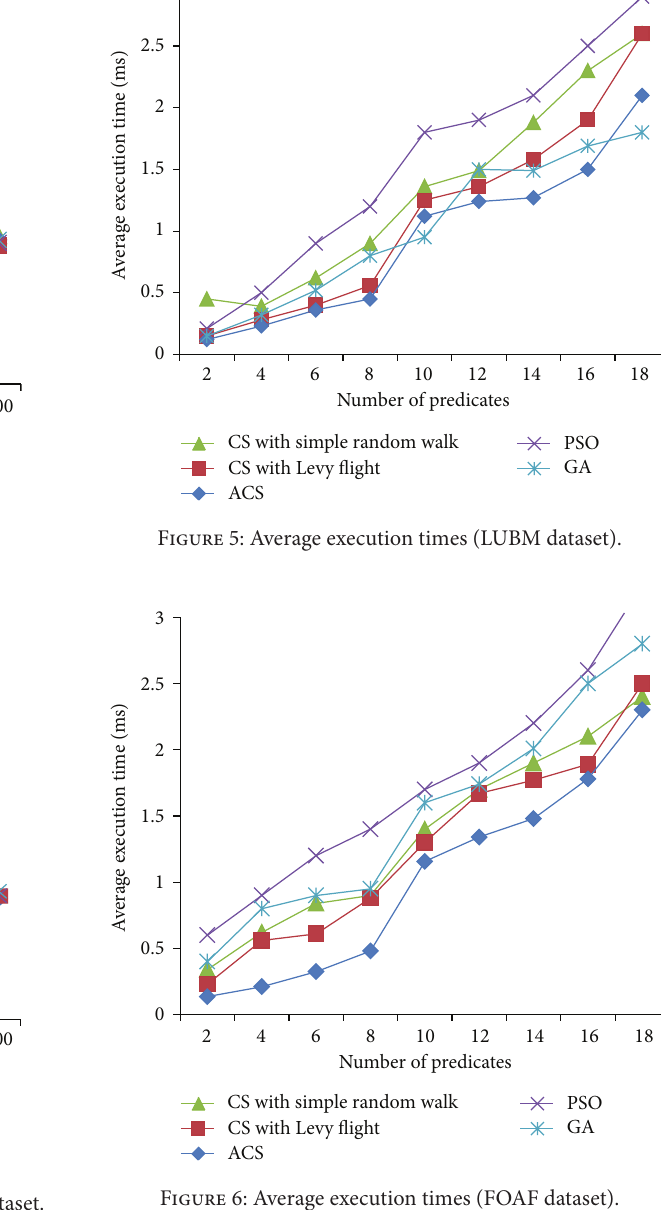
Figure 4: Evolution of best fitness for CIA World Factbook dataset.